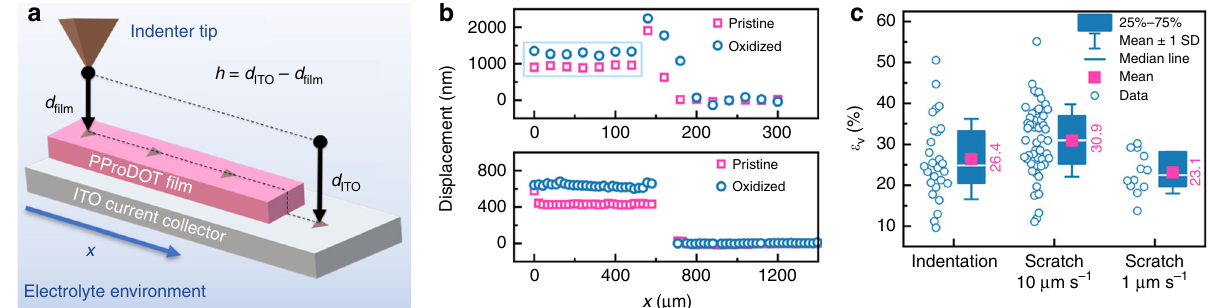
Fig. 2 In situ thickness measurement. a Sketch of the thin fi lm thickness measurement by the environmental nanoindentation method. d fi lm ( d ITO ) denotes the travel displacement of the tip when the contact between the tip and the fi lm (ITO) is detected. b Thickness of PProDOT in the pristine and oxidized states. The upper panel shows tip displacement measured by targeted indentation. The lower panel shows the tip displacement in the x -direction measured by the scratch test. For both methods, the step height denotes the thickness of the fi lm. c A volumetric strain ε V in the range of 20 – 30% is determined for PProDOT upon oxidation using the scratch and targeted indentation